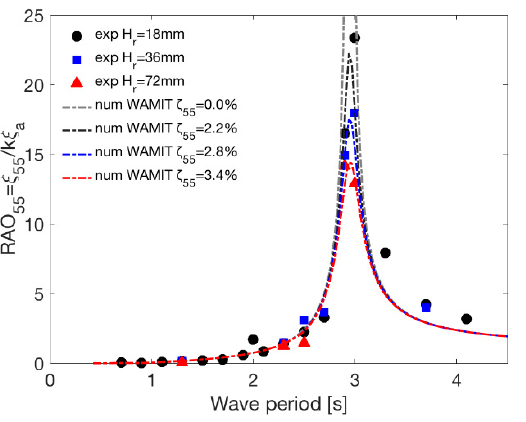
Figure 13. RAO pitch motion result comparisons between the experiment and WAMIT numerical calculations for different external damping levels.